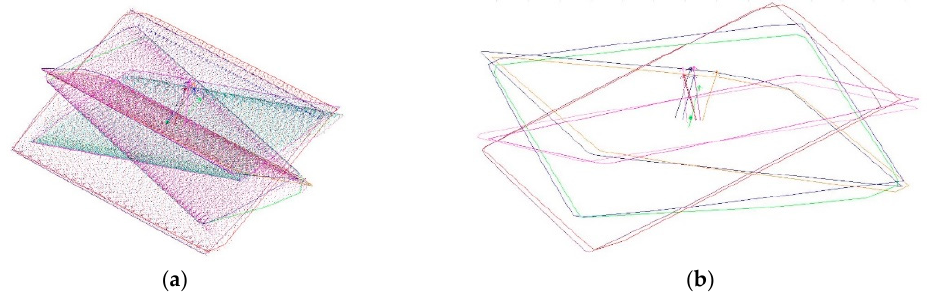
Figure 8. ( a ) Scanned; ( b ) estimated planes and intersection points.